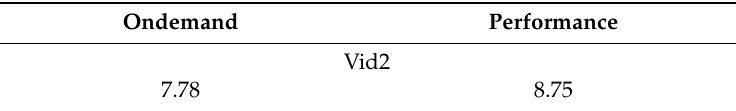
Table 4. Energy used through cloud computing solution.